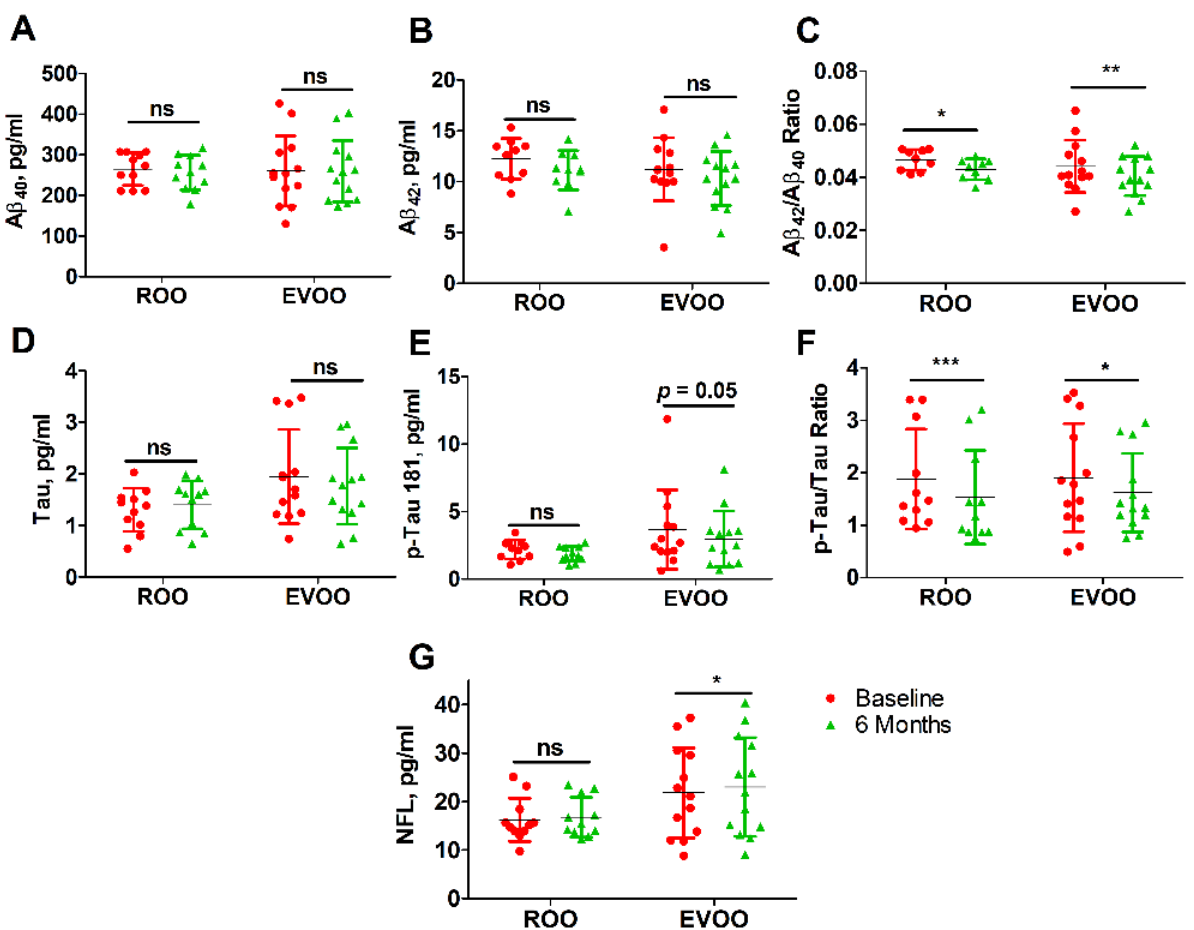
Figure 3. Effect of ROO and EVOO on changes in blood levels of AD biomarkers in MCI participants after 6 months of daily consumption. ( A ) A β 40 , ( B ) A β 42 , ( C ) A β 42 /A β 40 ratio, ( D ) t-Tau, ( E ) p-Tau 181, ( F ) p-Tau/t-Tau ratio, and ( G ) NfL. Data are presented as mean ± SD; ns is not significant, * p < 0.05, ** p < 0.01, *** p < 0.001 between baseline and 6 months post olive oil consumption.